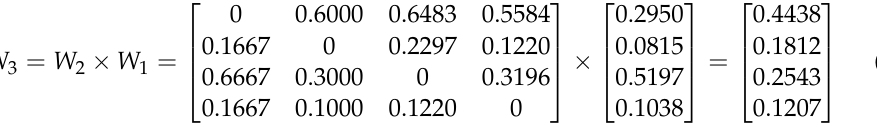
Figure 3. The hierarchy and network structure.